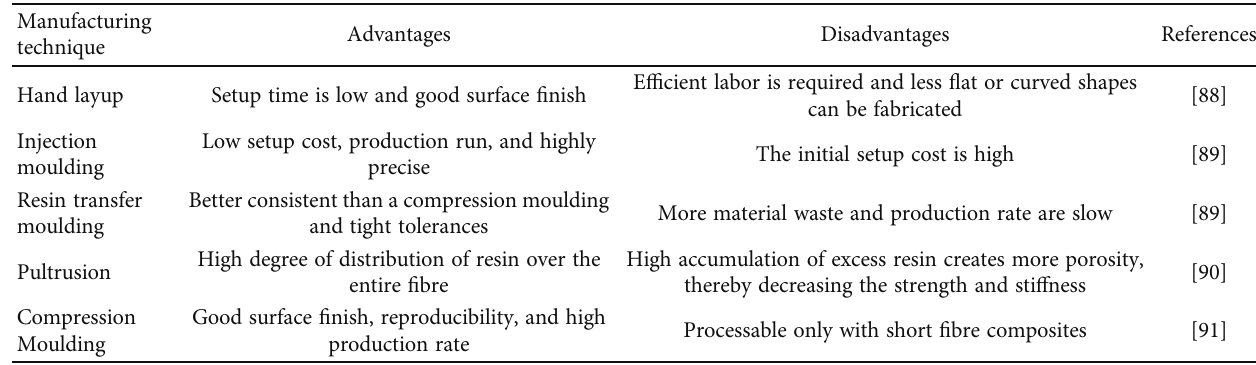
Table 4: Advantages and disadvantages of manufacturing